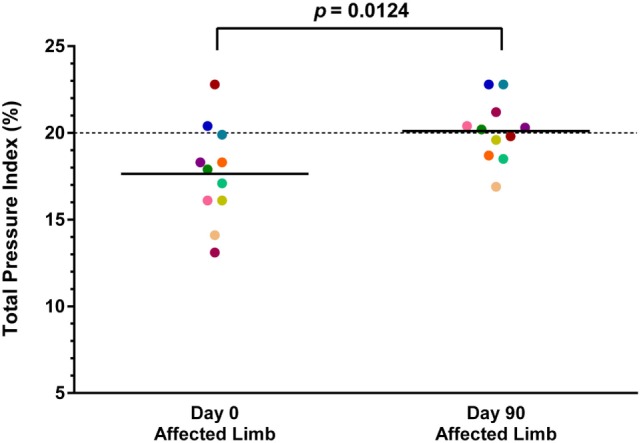
A statistically significant difference was found between the treated limb total pressure index percent (TPI%) at day 0 and day 90 (p = 0.0124) (solid line, mean; dotted line, normal TPI%).